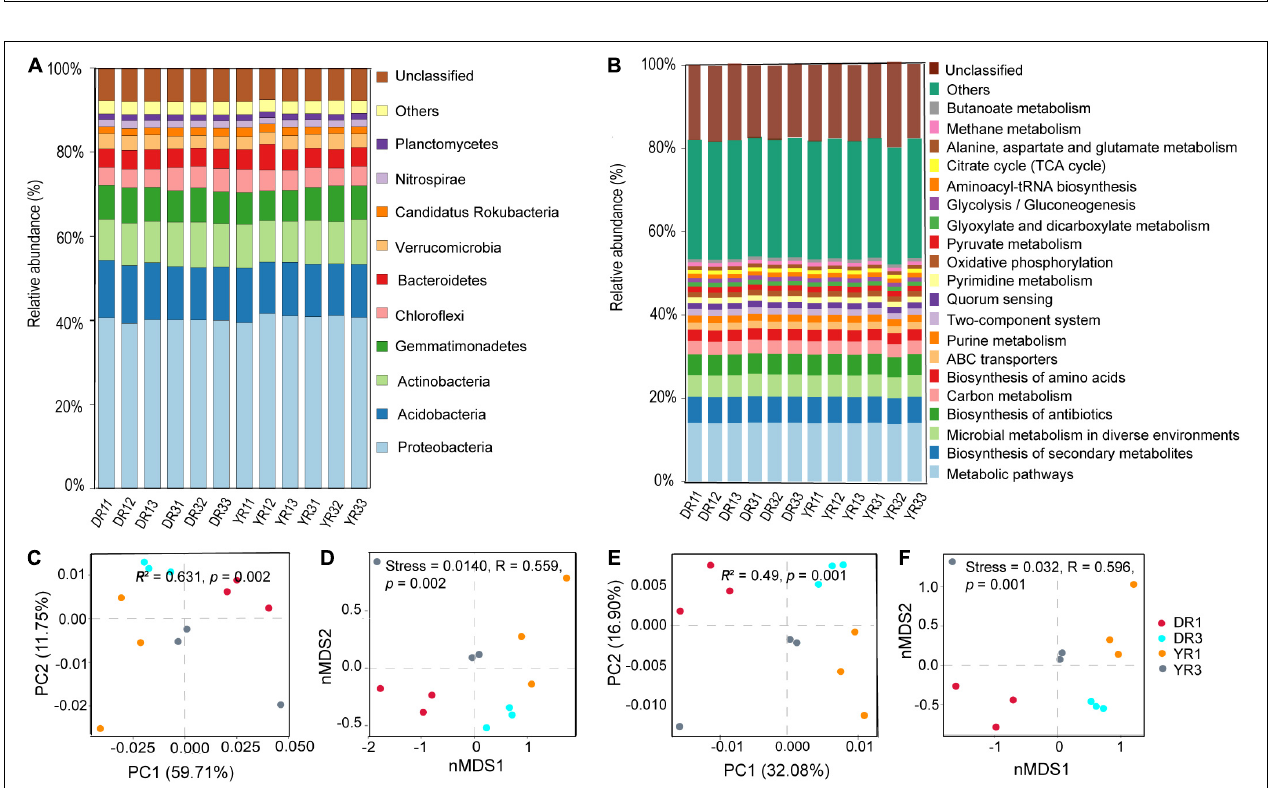
FIGURE 4 | The relative abundance and β -diversity of microbial communities and KEGG pathways. (A) The relative abundance of the microbial community at the phylum level. Only the first 10 most dominant microorganisms are presented. (B) The relative abundance of KEGG pathways at level 3. Only the first 20 most dominant KEGG pathways are presented. (C) Bray–Curtis PCoA and PERMANOVA analysis based on microbial species. (D) Bray–Curtis nMDS and ANOSIM analysis based on microbial species. (E) Bray–Curtis PCoA and PERMANOVA analysis based on KEGG pathways. (F) Bray–Curtis nMDS and ANOSIM analysis based on KEGG pathways. DR1_ and DR3_ (_ = 1, 2, 3) represent the rhizosphere soil in non- and severely diseased groups from Dali, respectively. YR1_ and YR3_ represent the corresponding samples from Yuxi.